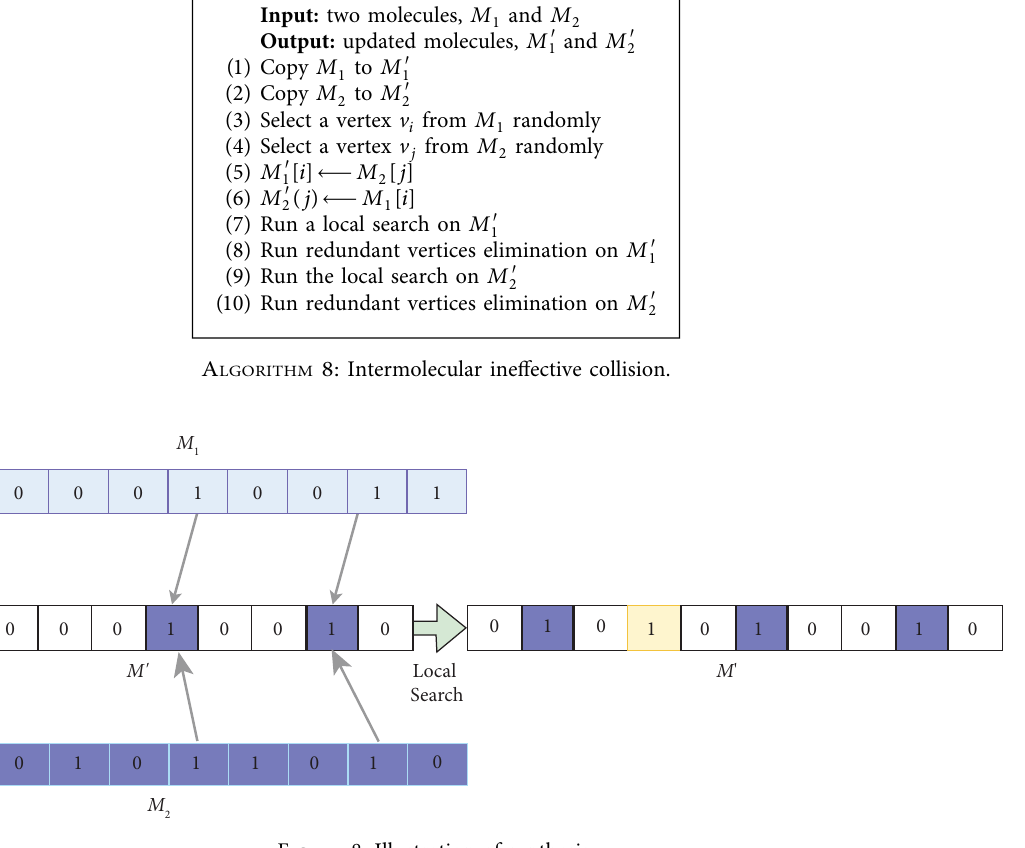
Figure 8: Illustration of